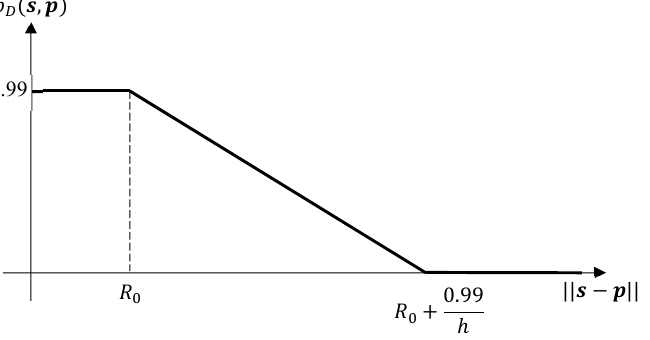
Figure 5. The detection probability given by (67) decreases as the sensor-object distance increases.